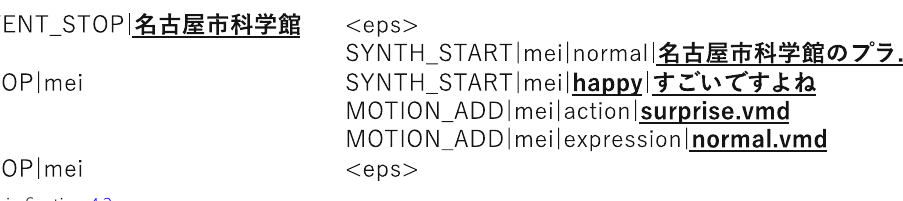
Fig. 7 FST generated from input in Section 4.2